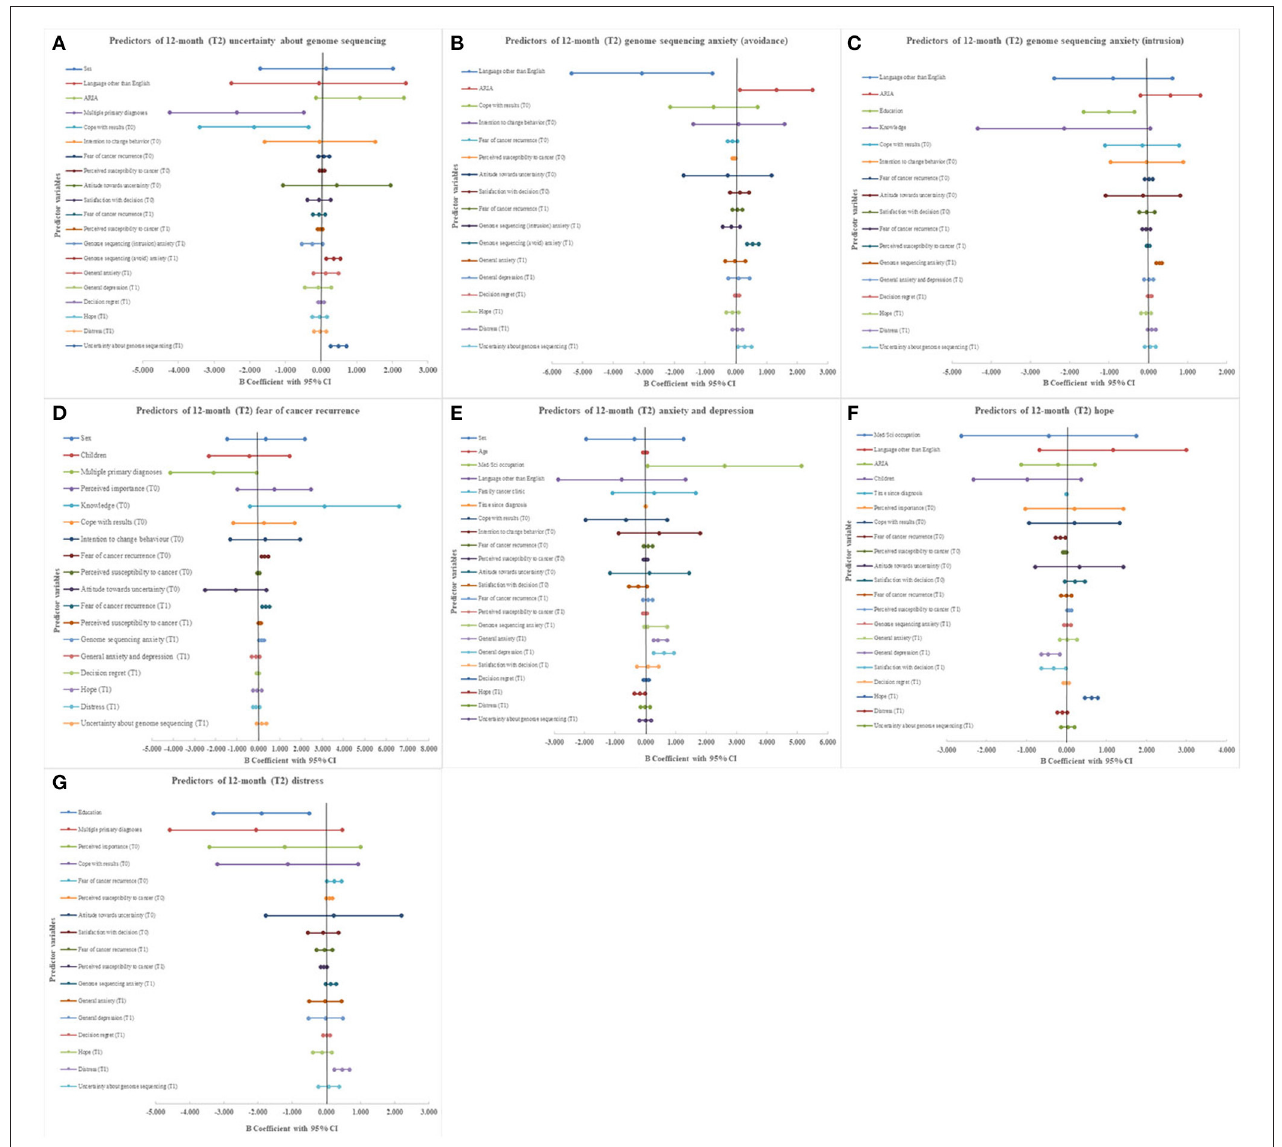
FIGURE 2 | Forest plots presenting results of multiple regression analysis for predictors of psychological outcomes in cancer patients undergoing genome sequencing. (A) 12 month (T2) uncertainty about genome sequencing. (B) 12 month (T2) genome sequencing anxiety (avoidance). (C) 12 month (T2) genome sequencing anxiety (intrusion). (D) 12 month (T2) fear of cancer recurrence. (E) 12 month (T2) anxiety and depression. (F) 12 month (T2) hope. (G) 12 month (T2)